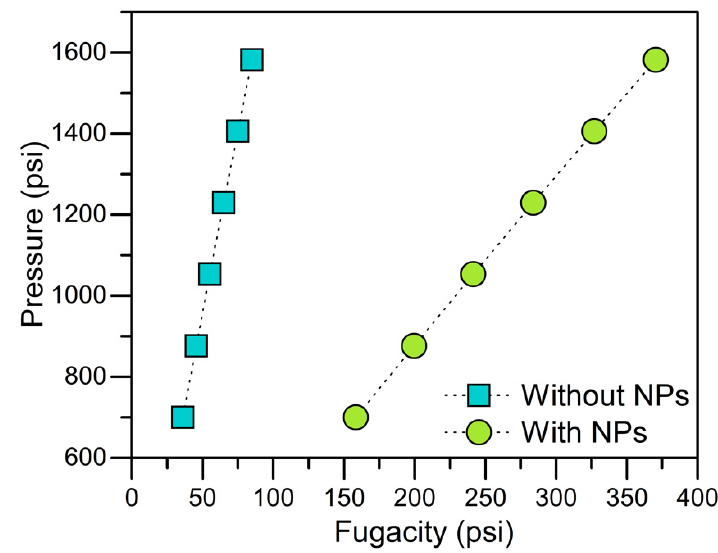
Figure 5. Fugacity of H 2 generated during the steam injection in the presence and absence of nanoparticles on HO1 between reservoir pressure (700 psi) and overburden pressure (1600 psi) at the steam injection temperature (270 °C). Table 2. Temperature of coordinates of HO1 during the first steam injection (without nanoparticles) and the steam injection after nanofluid soaking with porous medium (with